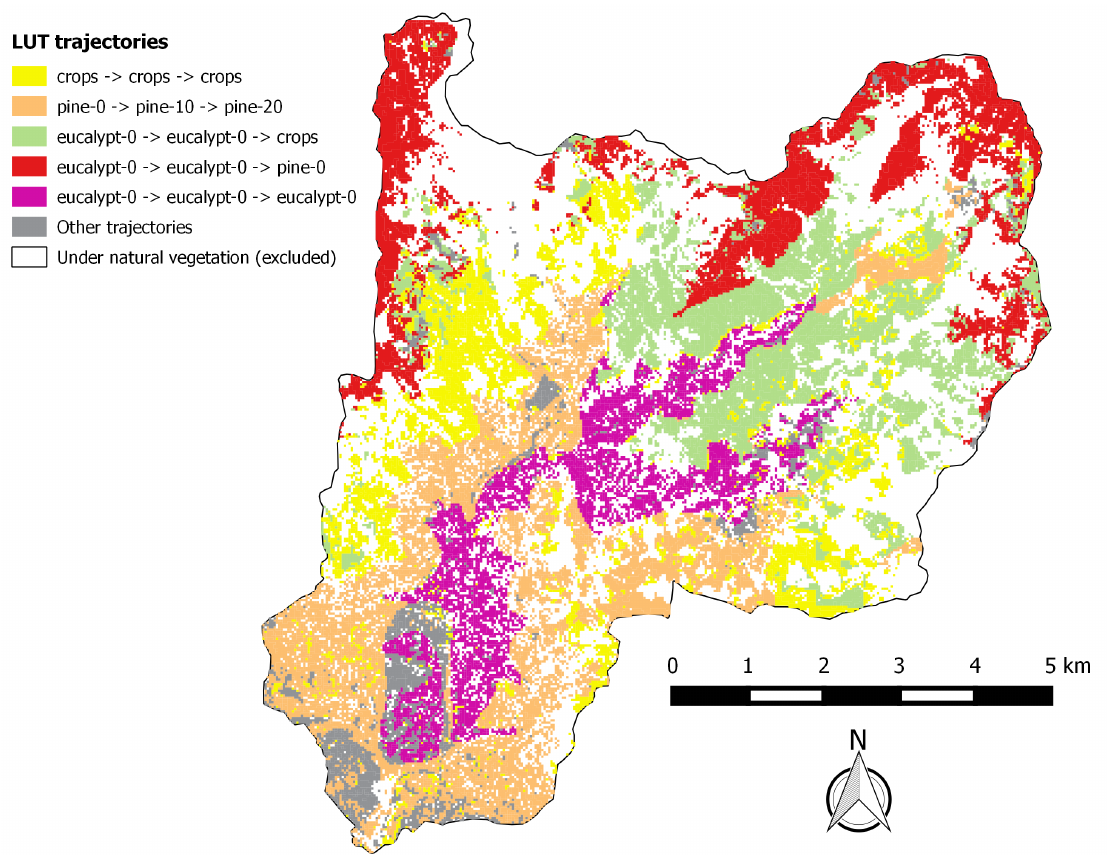
Figure 4. Distribution of land use trajectories over the Tabacay catchment that optimizes land performance, obtained by applying BIOLP for the reference scenario considering income and carbon stock thresholds. The category “Other trajectories” in the legend comprises 20 different trajectories that were assigned by BIOLP to relatively small areas.